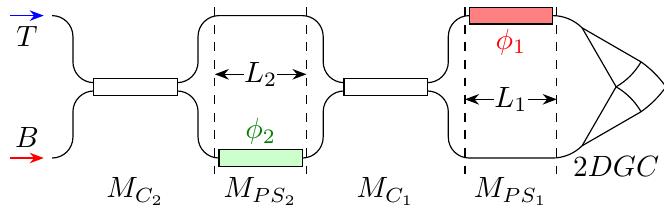
Figure 11. Schematic of the integrated polarisation controller. The labels are as in Figure